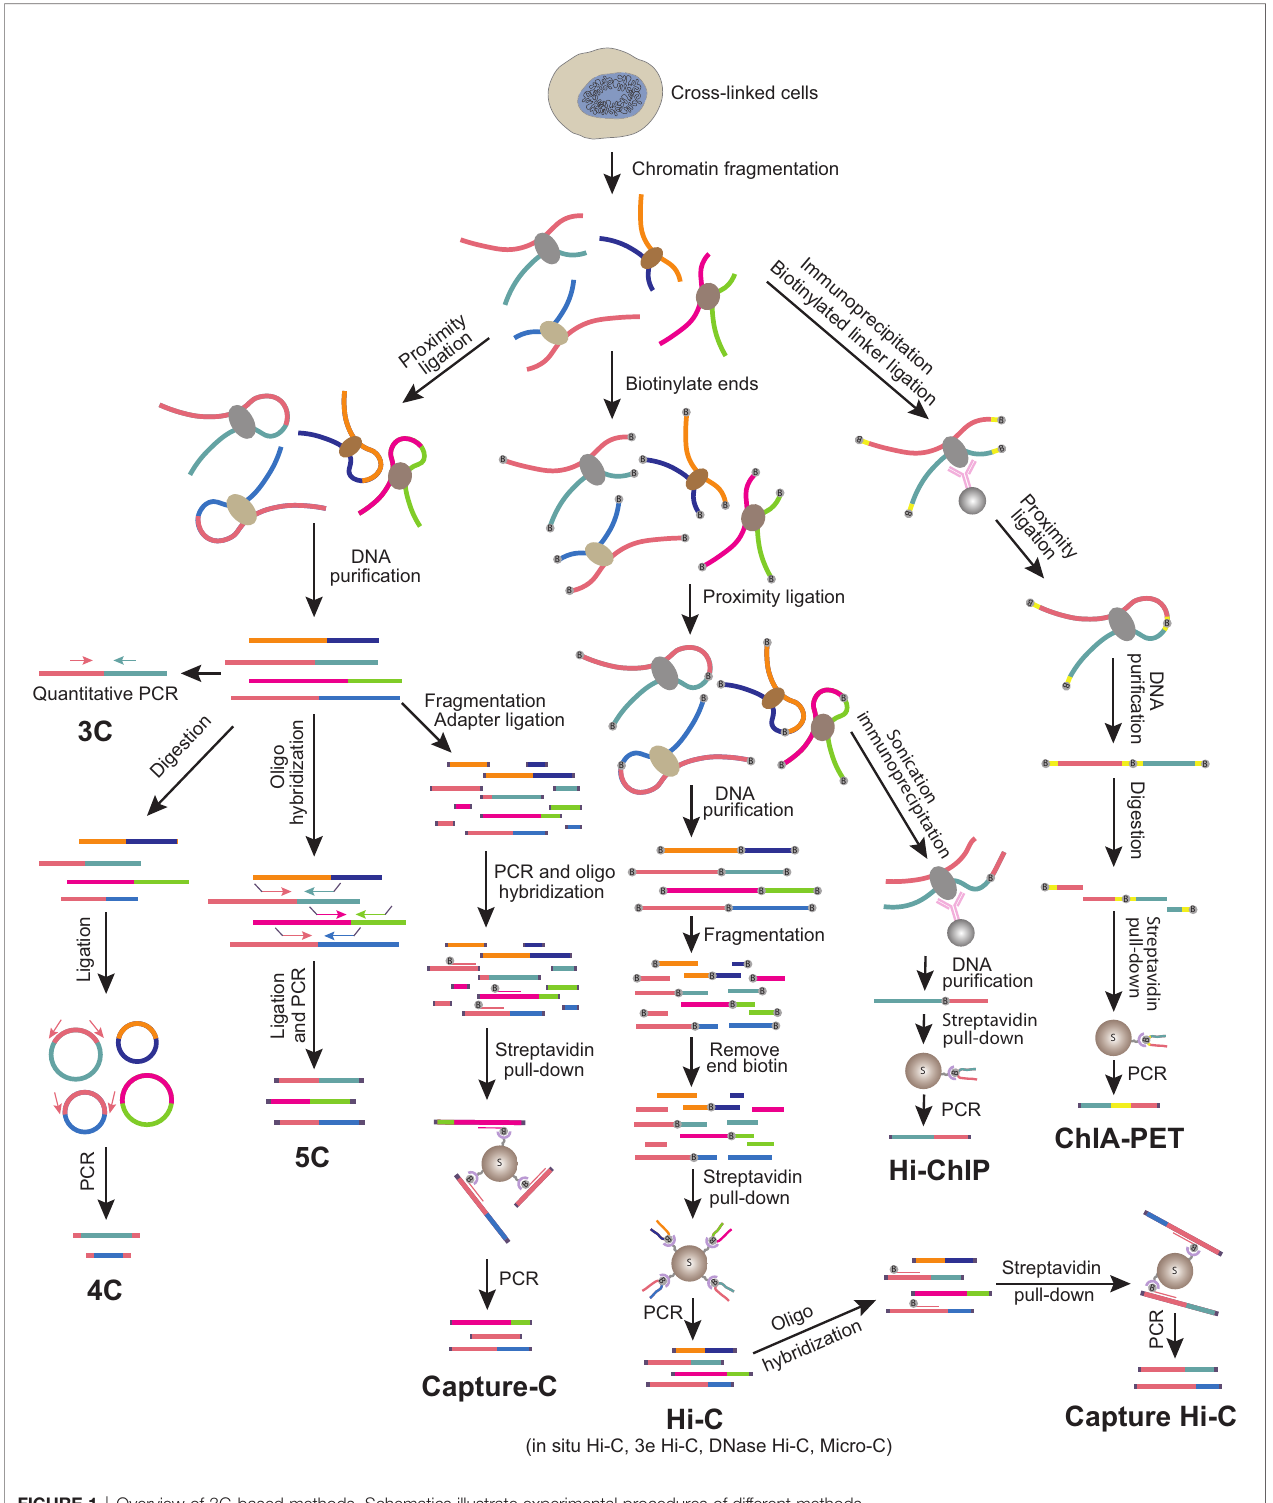
FIGURE 1 | Overview of 3C-based methods. Schematics illustrate experimental procedures of different